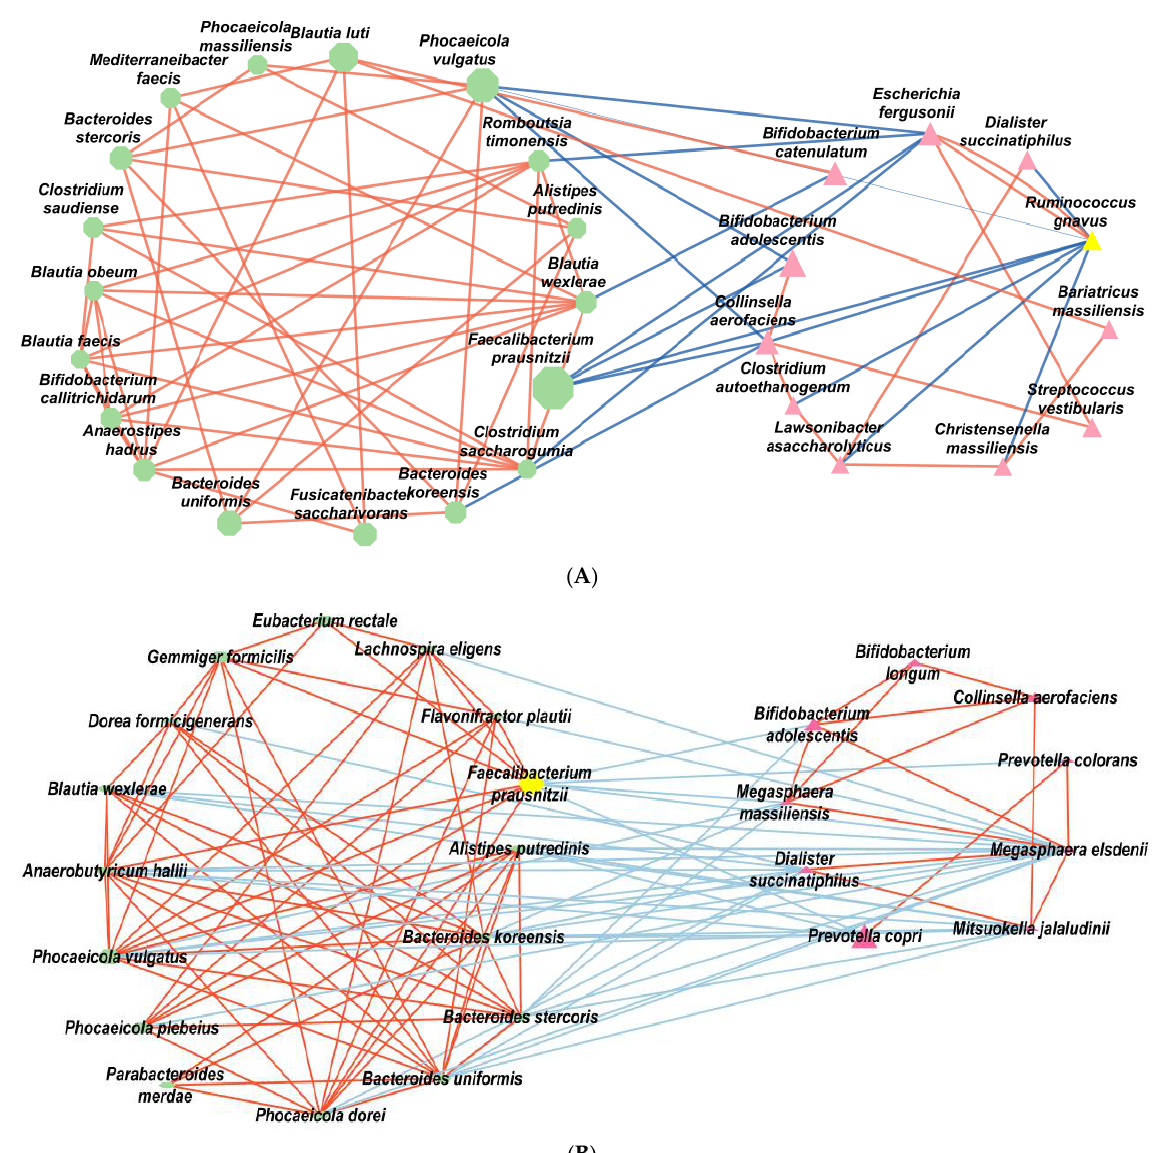
Figure 5. Network of primary bacteria in the T2DM and healthy groups according to each enterotype; ( A ) ET-L; ( B ) ET-P. Red and blue lines indicate positive and negative correlations with Pearson correlation coefficients >0.1, respectively. ET-L: Enterotype Lachnospiraceae; ET-P: Enterotype Prevotellaceae.